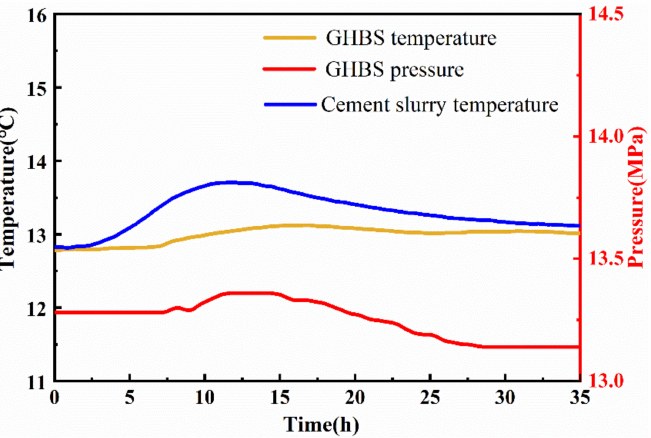
Figure 21. Damage of GHBS caused by hydration heat of CSM1 5%